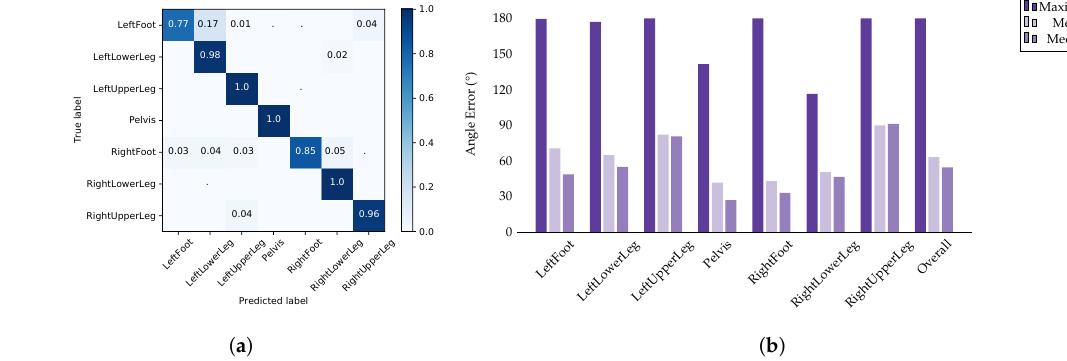
Figure 11. Evaluation results on dataset B , test case 1: ( a ) confusion matrix for the I2S assignment problem; and ( b ) angle errors over all windows, axes and considered (nine) IMU configurations for the I2S alignment problem for test case